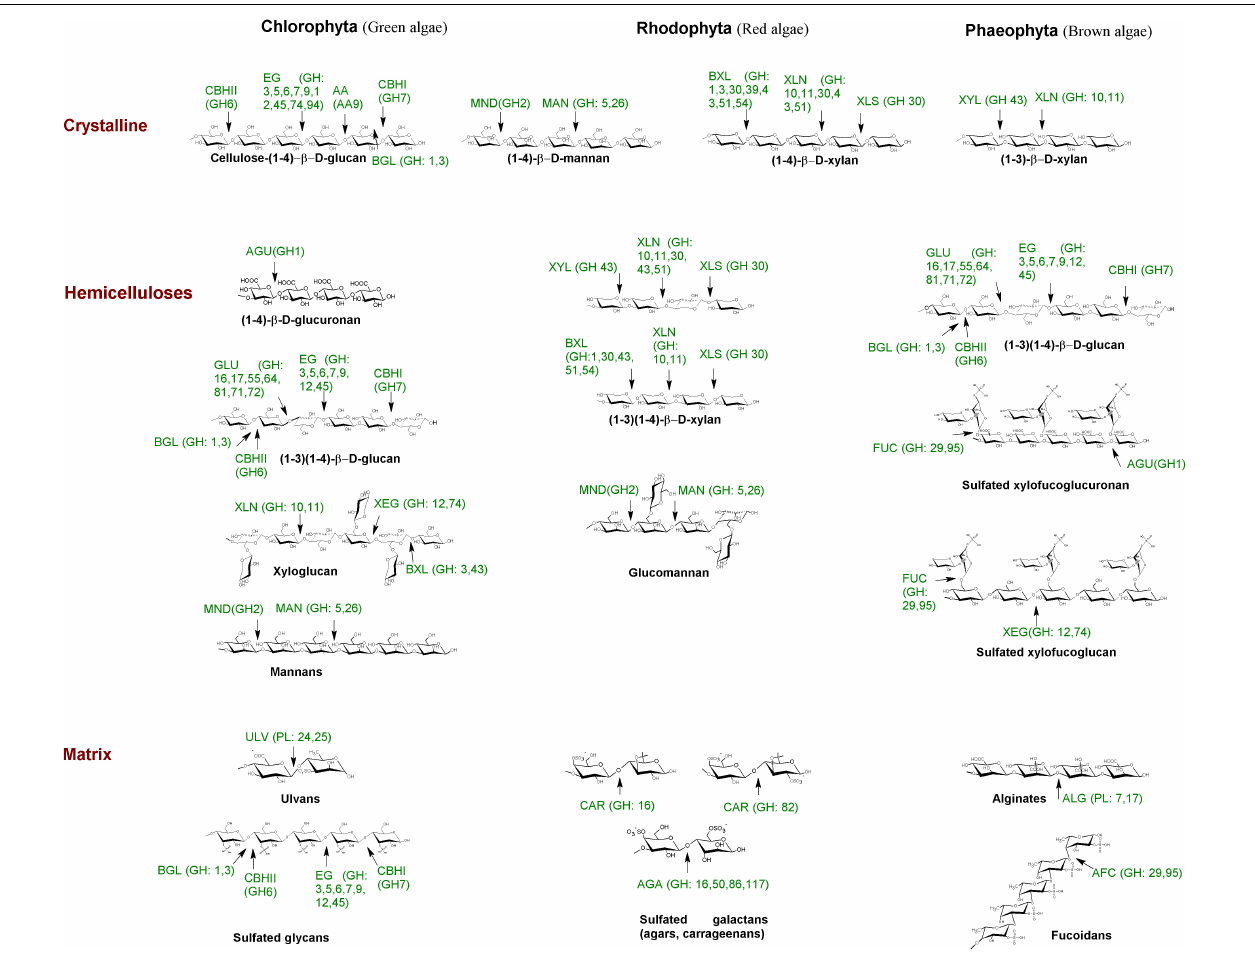
FIGURE 1 | Schematic representation of algae cell wall polysaccharides and corresponding polysaccharide-degrading enzymes. AA, monooxygenase; AFC, α -fucosidase; AGA, agarase; AGU, gucuronidase; ALG, alginate lyase; BGL, β -1,4-glucosidase; BXL, β -1,4-xylosidase; CAR, carrageenase; CBHI, exo- β -glucanase (reducing end); CBHIl, exo- β -glucanase cellobiohydrolase (non-reducing end); EG, endo- β -1,4-glucanase; GLU, β -1,4/1,3-glucanase; MAN, β -1,4-endomannanase; MND- β -1,4-mannosidase; ULV, ulvanlyase; XEG, xyloglucan- β -1,4-endoglucanase; XLN, β -1,4/1,3-endoxylanase; XLS, β -1,4-xylosidase (reducing end); XYL, β -1,3-xylosidase (van den Brink and de Vries, 2011; Pluvinage et al., 2013; Rytioja et al., 2014; Zhao et al., 2014; Zhu et al., 2016; Gao et al., 2017; Ulaganathan et al., 2017). Algae polysaccharides content and structures were presented with the use of data reported by Synytsya et al. (2015). Enzyme abbreviations were applied according the EC and CAZy classification. Algae polysaccharide-degrading enzymes were shortened according to the first letters of the enzymatic